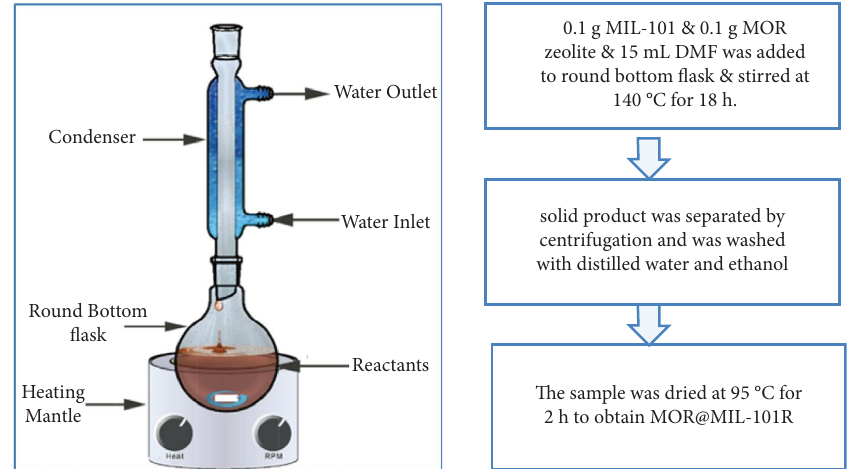
Figure 9: Schematic of refux setup modifed from [42].